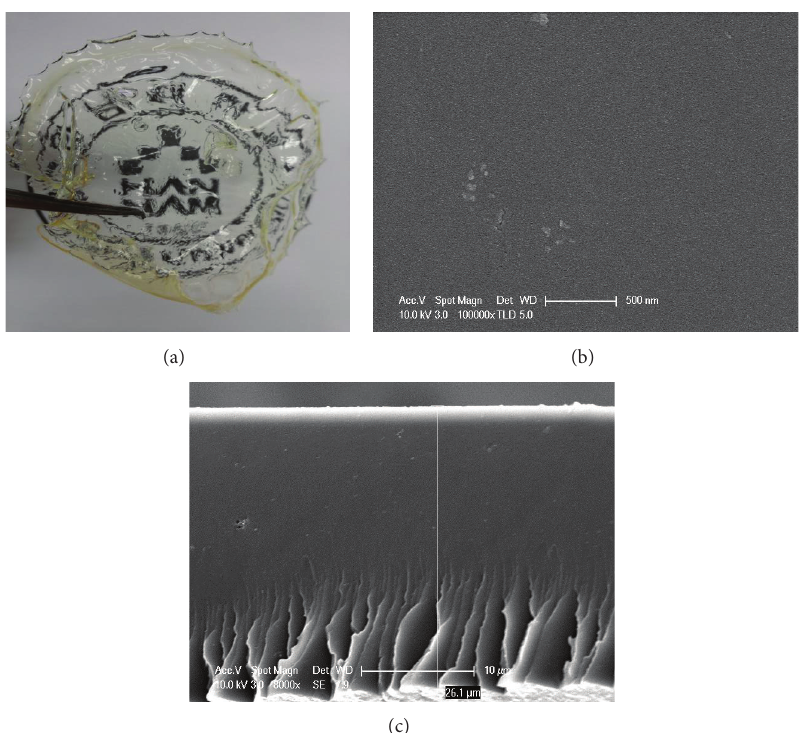
Figure 4: Photograph (a), the surface SEM images (b), and cross-section SEM image (c) for the AEM prepared photocopolymerization.